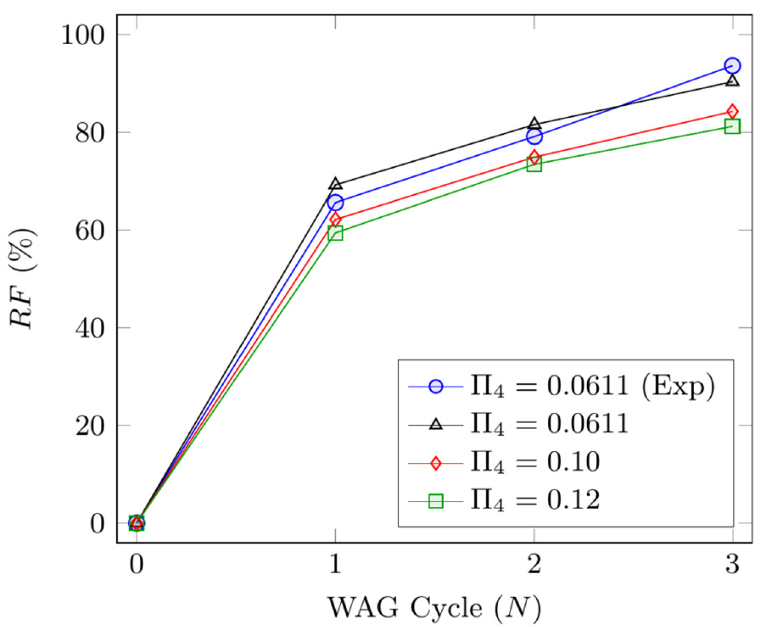
Figure 11. Impact of oil to gas viscosity ratio ( π 4 ) on the recovery performance of near-miscible WAG injection based on the GEP correlation.